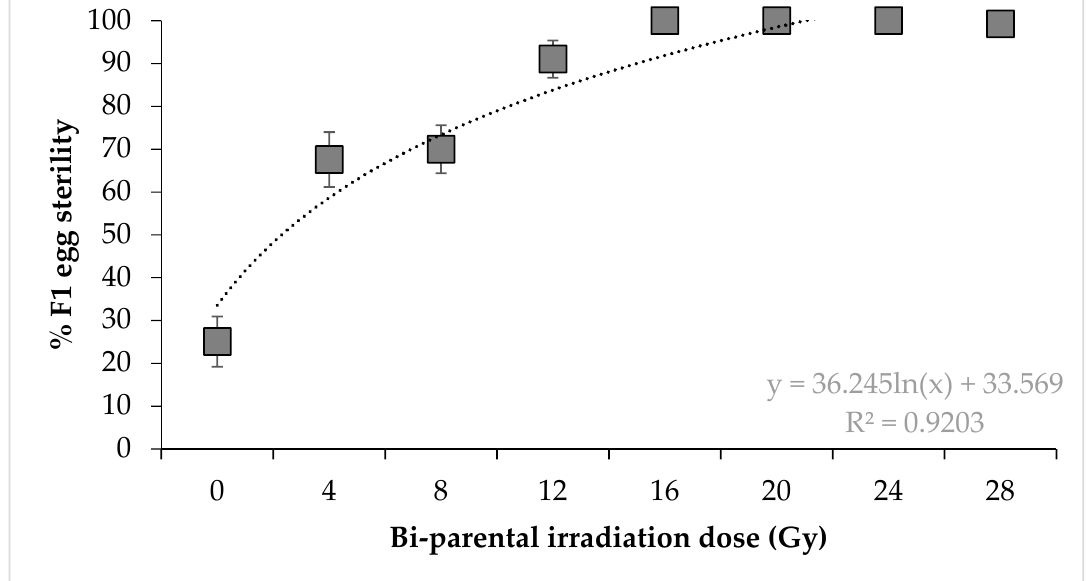
Figure 3. Sterility of Nezara viridula eggs after crosses of irradiated females with irradiated males treated at the same dose. Error bars show standard error (n = 15 crosses per dose).